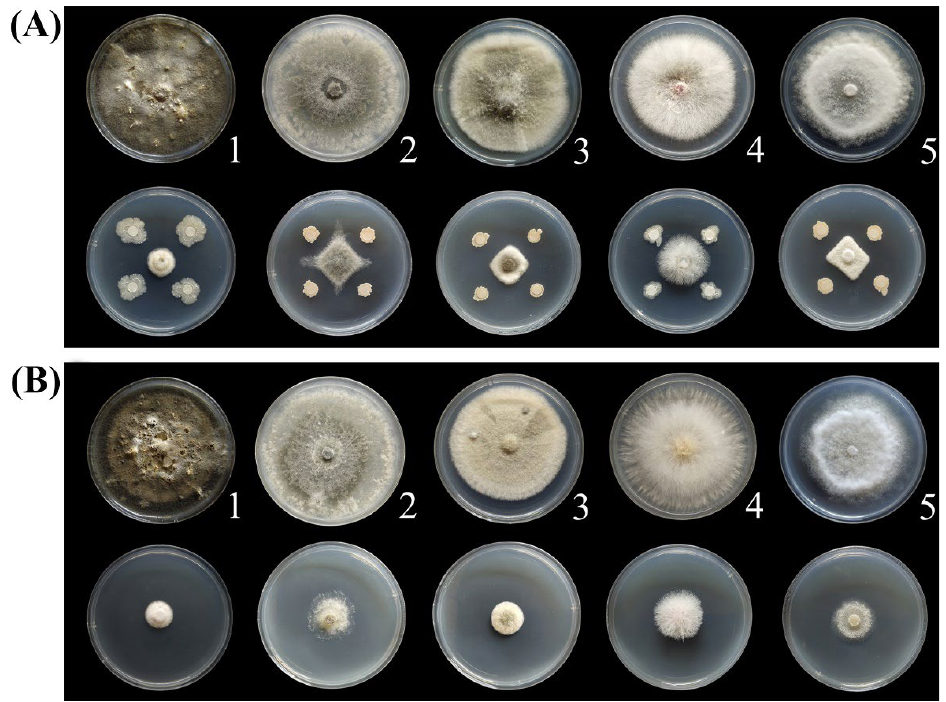
Figure 2. Inhibitory effect of BQ-33 suspension ( A ) and 200 mL L − 1 sterile supernatant (SS) ( B ) on fungal pathogens. (1) Didymella glomerata , (2) Botryosphaeria dothidea , (3) Alternaria alternata , (4) Fusarium oxysporum and (5) Phomopsis cauloides .